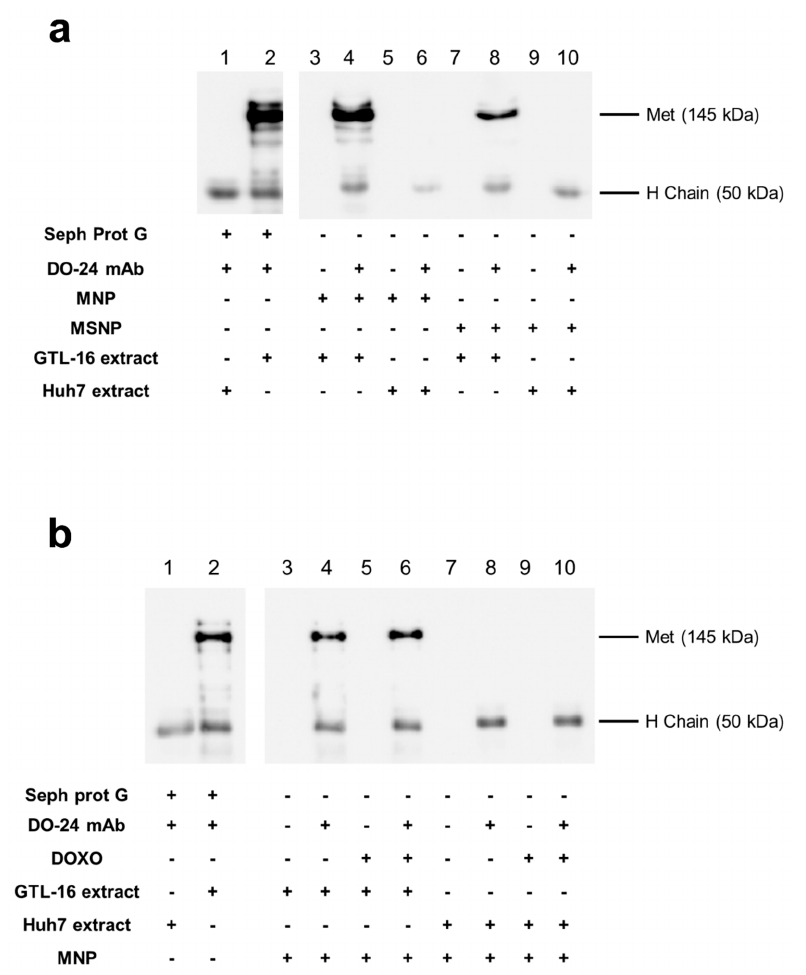
Figure 5. Immunocompetence of the functionalized magnetic nanoparticles. Nanoparticles